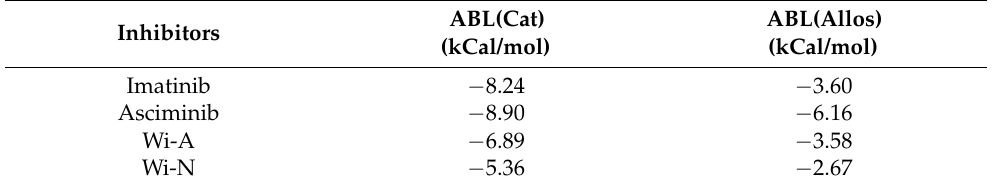
Table 1. Binding energies obtained by separate docking of inhibitors at each site of ABL